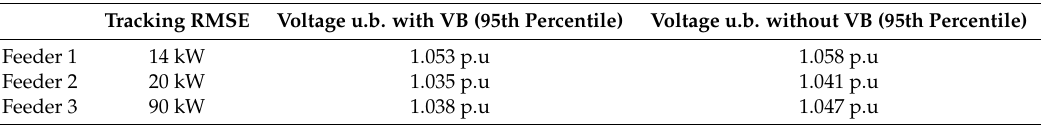
Table 4. Tracking root-mean-square error (RMSE) error and 95th percentile of the nodal voltage distribution when virtual batteries are utilized.